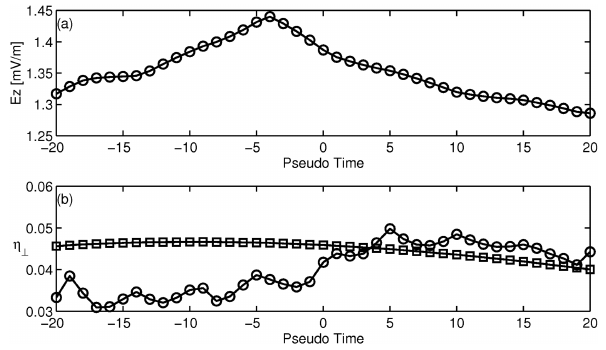
Figure 4. (a) Plot of the measured axial electric field in the reconstruction interval, 571 Fig. 4. (a) Plot of the measured axial electric field in the recon- evaluated in the moving frame and based on the data from spacecraft 3. (b) Plot of the 572 struction interval, evaluated in the moving frame and based on the dimensionless resistivity � in the reconstruction interval used in the simulation (squares) 573 � data from spacecraft 3. (b) Plot of the dimensionless resistivity η ⊥ and recovered from the reconstruction (circles). 574 in the reconstruction interval used in the simulation (squares) and recovered from the reconstruction (circles).